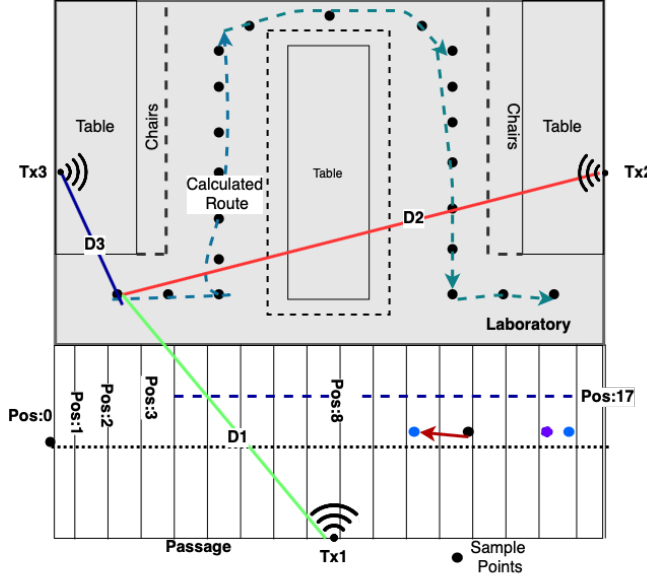
Figure 2. RSSI values for different